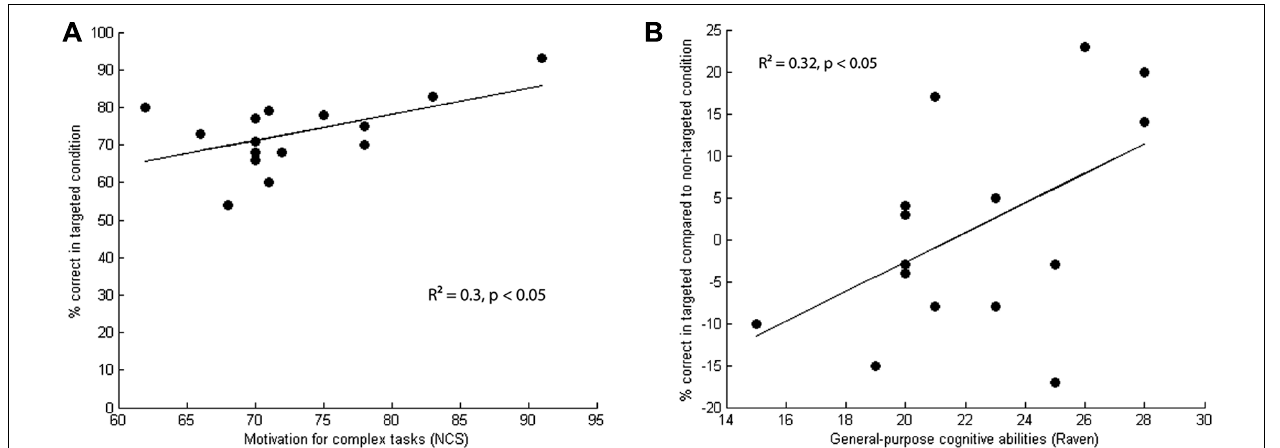
FIGURE 2 | Communicative success as evaluated by a new group of participants (in percentage correct) plotted against the psychometric indexes of the Communicators. (A) Communicators’ scores on motivation for complex tasks as indexed by the NCS ( R 2 = 0.3, p < 0.05, regression line is solid, data points represented as dots) drive communicative success in the communicative setting ( TARGETED condition). (B) Communicators’ scores on general intelligence as indexed by Raven’s Advanced Progressive Matrices (RAPM, R 2 = 0.32, p < 0.05, regression line is solid, data points represented as closed dots) drive communicative success in the TARGETED setting compared to the NON-TARGETED setting.